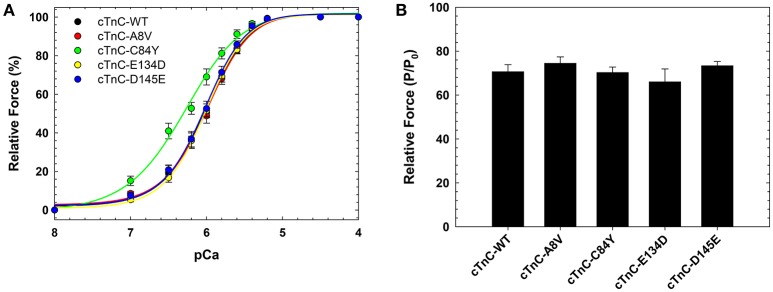
Ca2+ dependence of steady-state, isometric force development in rabbit soleus fibers reconstituted with recombinant cTnC proteins. (A) Ca2+ sensitivity of contraction in skinned fibers reconstituted with WT and HCM cTnC mutants (A8V, C84Y, E134D, and D145E). (B) Maximal force (pCa 4) following reconstitution normalized to the initial tension (P/P0) in fibers reconstituted with WT or HCM cTnC mutants. Regression parameter estimates of pCa50 and nHill, along with ΔpCa50 and relative maximal force values for these experiments are summarized in Table 1. Data are shown as mean ± S.E.M.